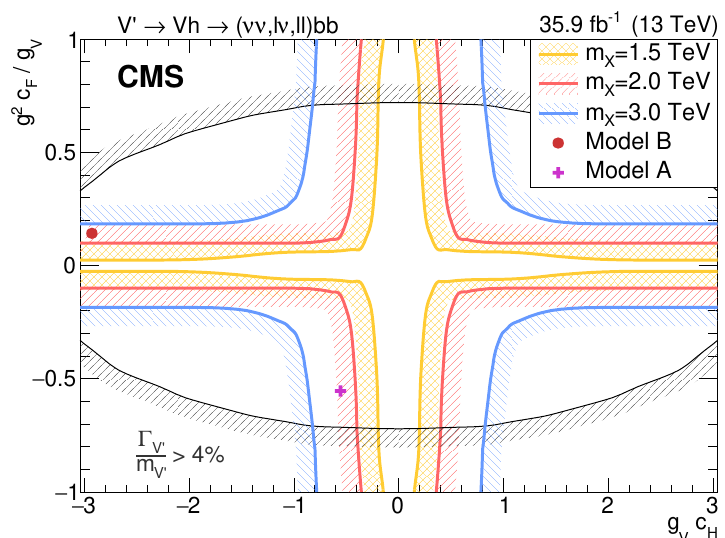
(cid:2) (cid:3) g V c H ; g 2 c F =g V for three